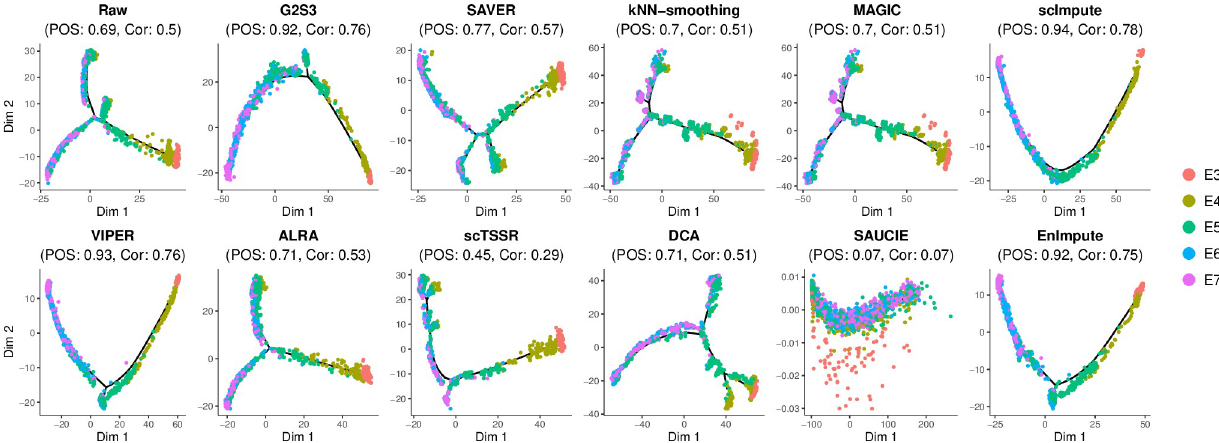
Fig 4. Visualization of cell trajectories in the raw and imputed data by all methods. Cells are projected into two-dimensional space using reversed graph embedding. Pseudotemporal ordering score (POS) and Kendall rank correlation coefficient (Cor) are used to measure the consistency between the actual embryonic days and the reconstructed